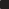
Impact of feeding the Non-encapsulated and PRS-based encapsulated L. plantarum 1.0344 on the levels of Pb in the feces of mice throughout the experimental period of 7-weeks: (A) Levels of Pb in the feces of mice without lead nitrate in drinking water; (B) levels of Pb in the feces of mice with lead nitrate in drinking water. The significant difference (P < 0.05) shown by ∗; and (C) levels of Pb in the blood (μg/L) of mice presented with bar, in kidney (μg/g) of mice presented with  with dotted line, in liver (μg/g) of mice presented with  of mice with lead nitrate in drinking water. The significant difference (P < 0.05) shown by letters. Values are given as mean ± standard deviation (SD).